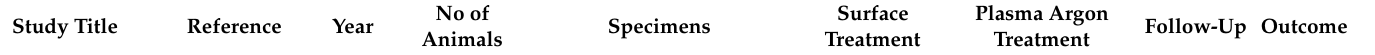
Table 1. Main characteristics and outcomes of the studies on plasma